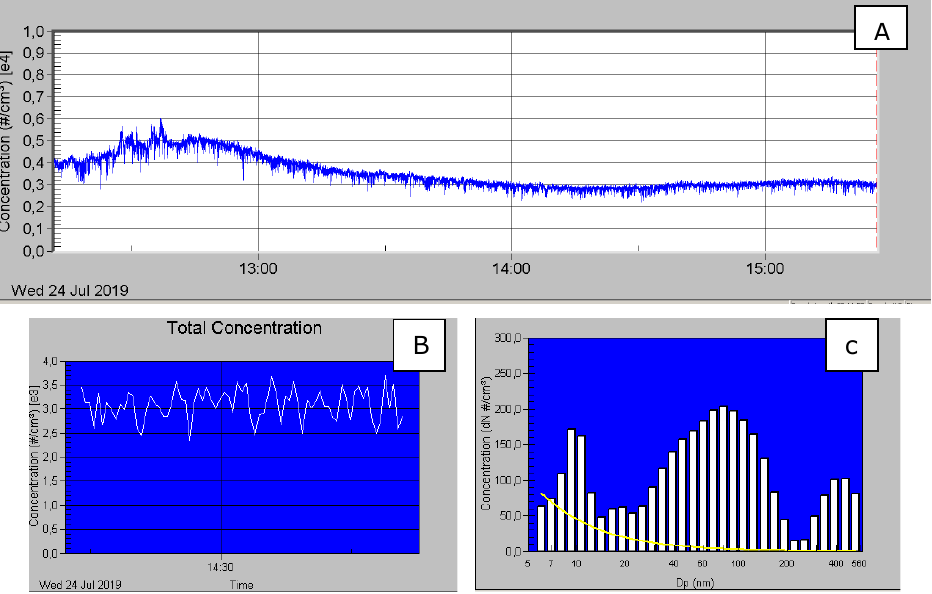
On the 24 th of July during printing PLA filament, an average concentration of 3,531 particles/cm 3 was observed, the concentration remained steady during printing (Figure 8A and Figure 8B). Typical submicron particle size distributions are shown in Figure 8C. Most of the particles emitted during printing were less than 200 nanometers with a number peak around 80 nm.